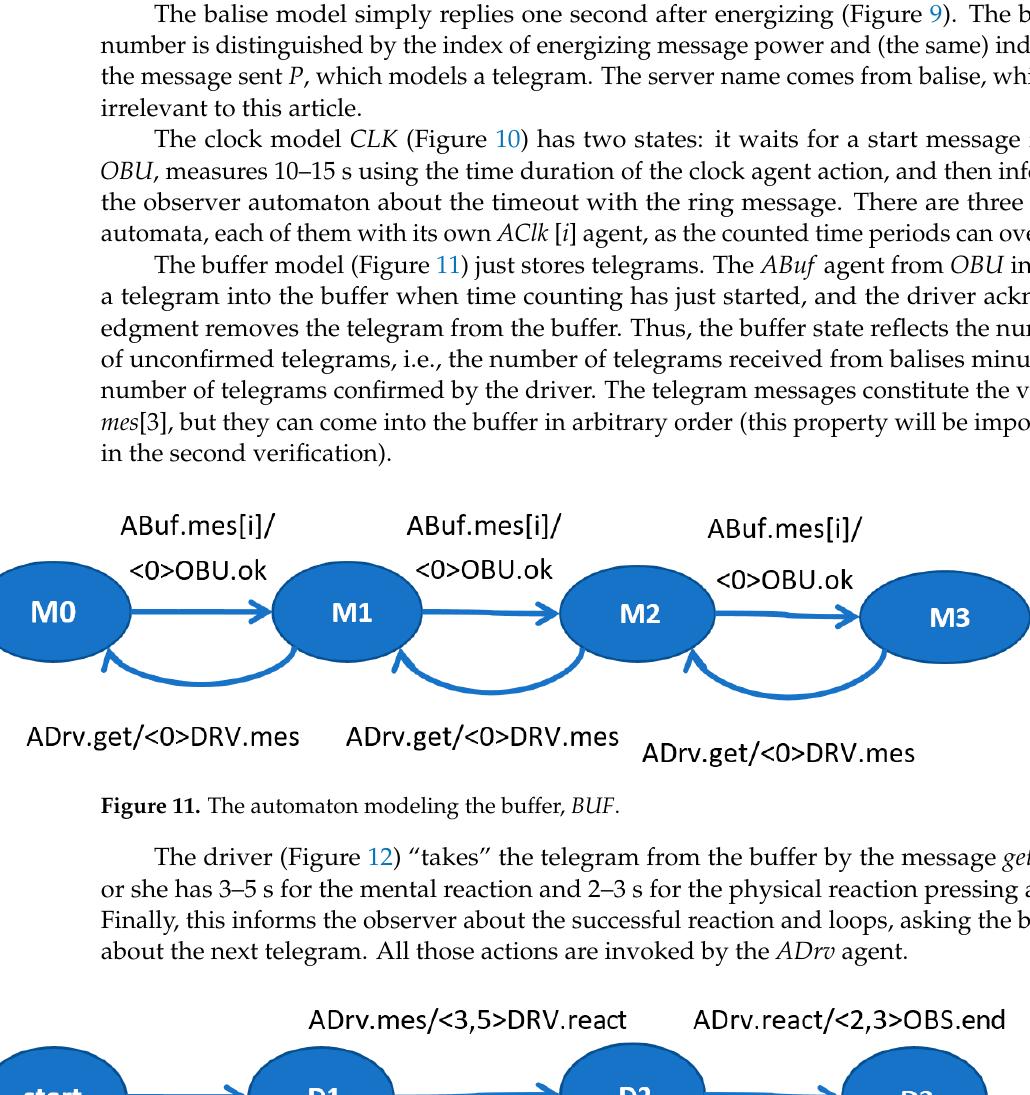
Figure 10. The automaton modeling an ith clock, CLK [i].